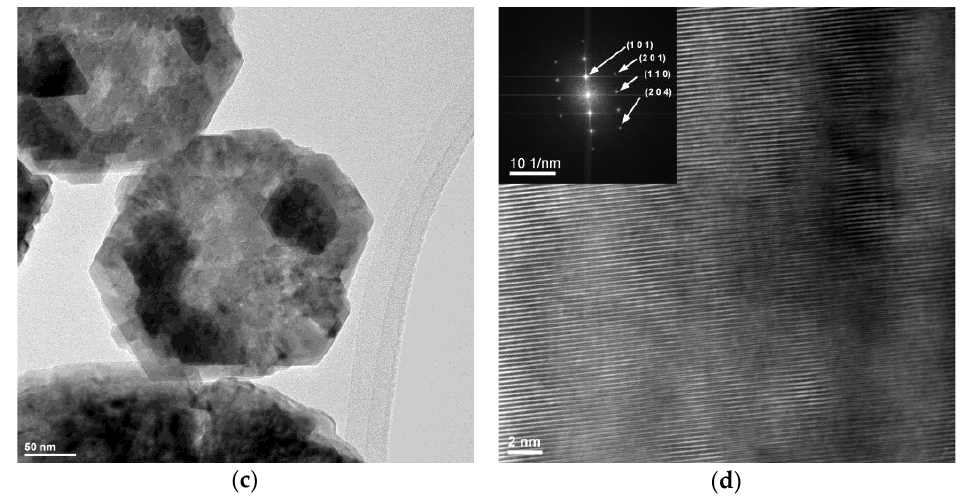
Figure 5. The TEM images for ZnO_G samples ( a ) 29,500× magnification; ( b ) 39,000× magnification; ( c ) 49,000× magnification; ( d ) high resolution TEM and identified planes of hexagonal ZnO (JCPDS card no. 80-0075).